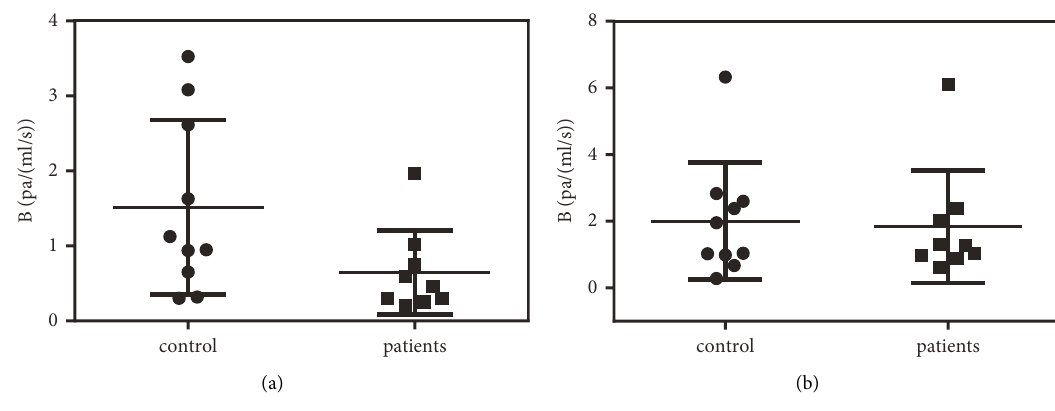
Figure 7: Flow resistance of LPV and RPV: (a) LPV (b) RPV. Table 2: Flow resistance coefficients ( B ) at different